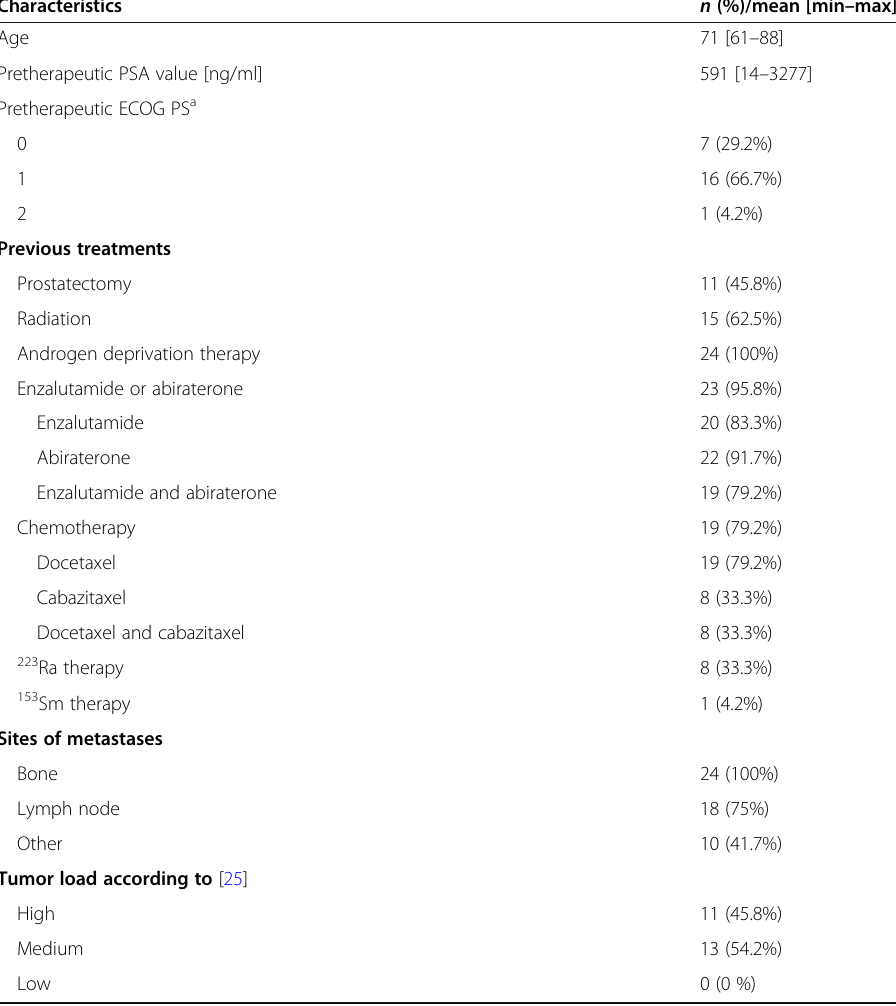
Table 1 Patient characteristics